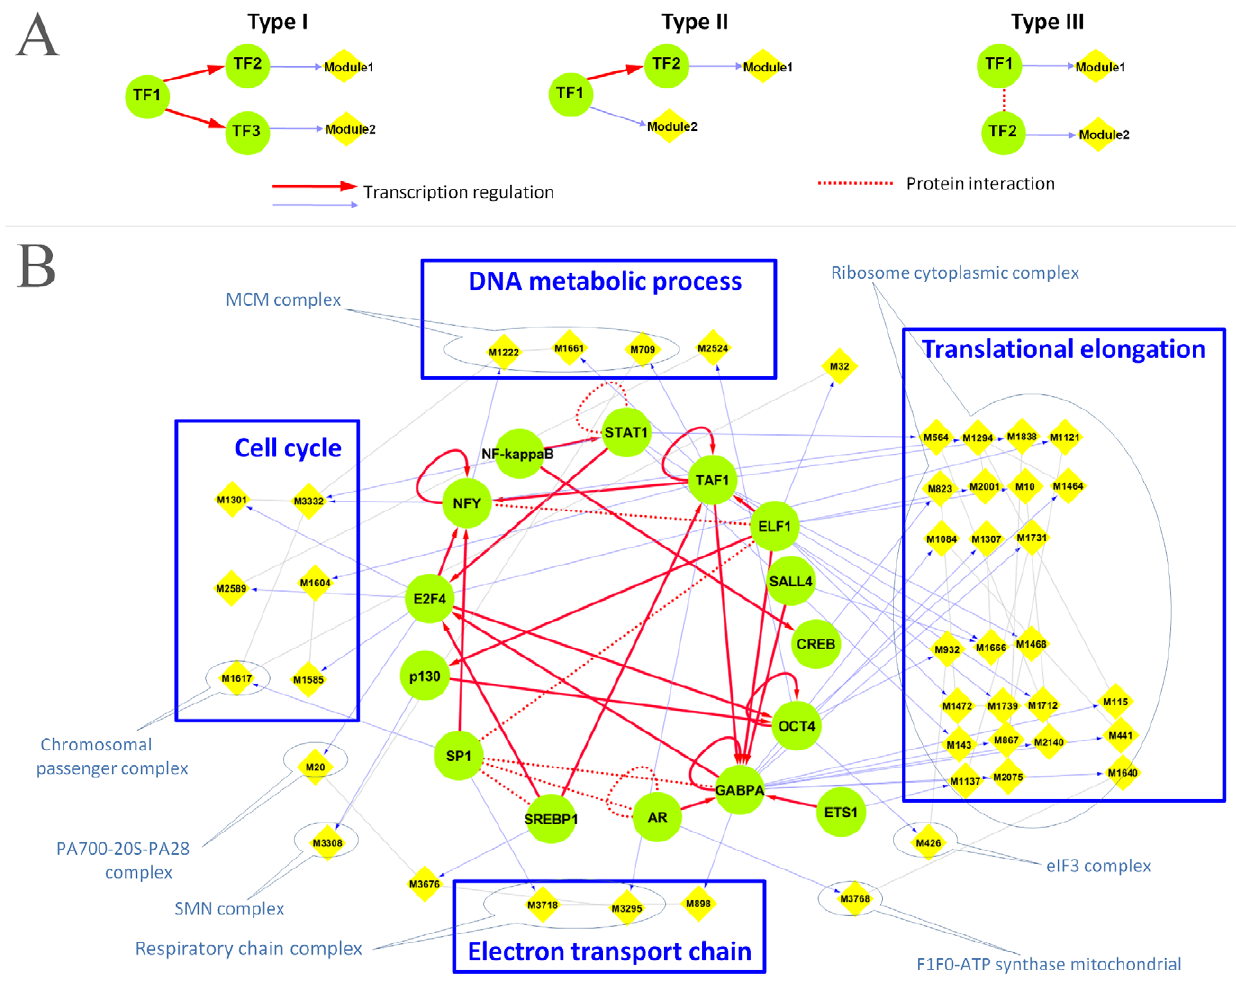
Figure 9. Reconstruction of transcriptional regulatory networks. ( A ) Three types of possible transcription networks that could explain a second-order correlation between two transcriptional modules. Given two modules controlled by two transcription factors, TF1 and TF2, respectively, the coactivation of the two modules implies cooperativity between TF1 and TF2. This relationship may be caused by a type I network in which the activities of TF1 and TF2 are controlled by common transcription factor(s) TF3; or a type II network, in which the activity of TF2 is controlled by TF1 or vice versa; or a type III network, in which TF1 and TF2 interact at the protein level. ( B ) A regulatory network reconstructed on the basis of the derived transcription networks. Green circles denote transcription factors, yellow boxes are transcription modules defined by RHSs (detailed information on these RHSs provided in Text S1), blue ovals denote protein complexes represented by the RHSs, and blue boxes highlight the biological processes in which the modules are